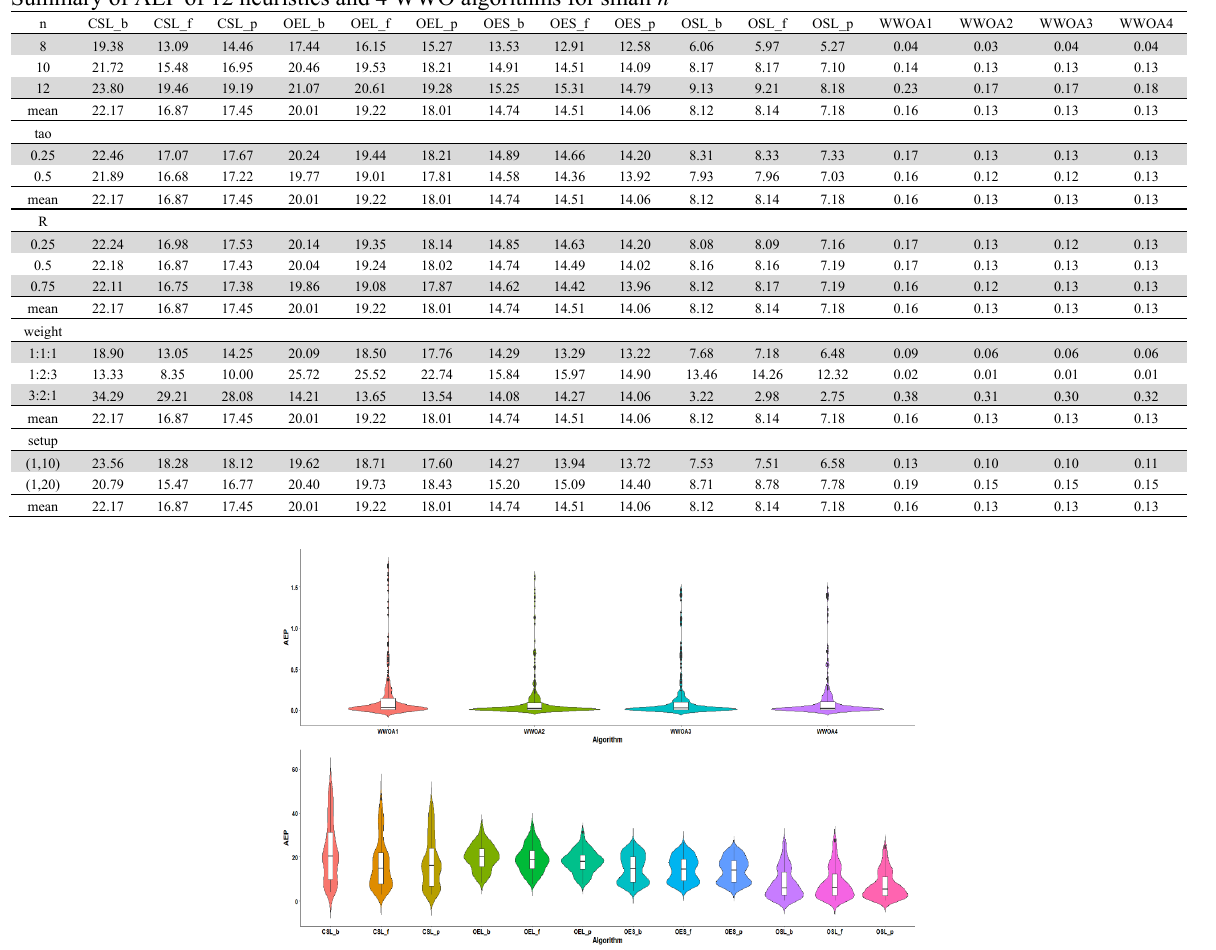
Table 4 summarizes the results in terms of AEP for levels of the Factors n, τ , R , weight, and setup; for (mo×mk), see Table 3. It can be observed that the AEP of all algorithms increases slightly as n increases from 8 to 12. Furthermore, Fig. 3 displays the violin plots of AEP (distributions) for the 12 heuristics and four WWO algorithms. Regarding the CPU times, 16 heuristics/algorithms cost less than 1 second.